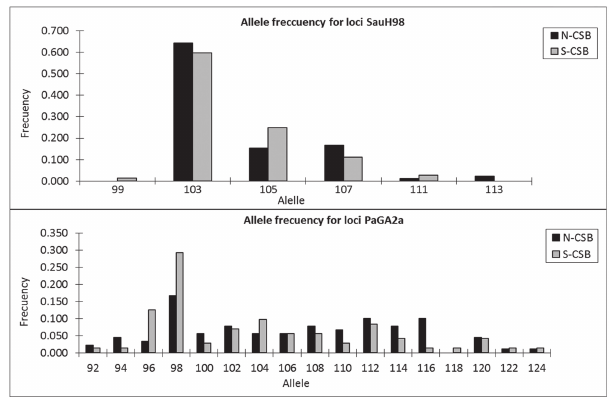
Fig. 4. Allele frequencies from both microsatellite loci of Pagrus pagrus : SauH98 and PaGa2a for N-CSB and S-CSB samples.